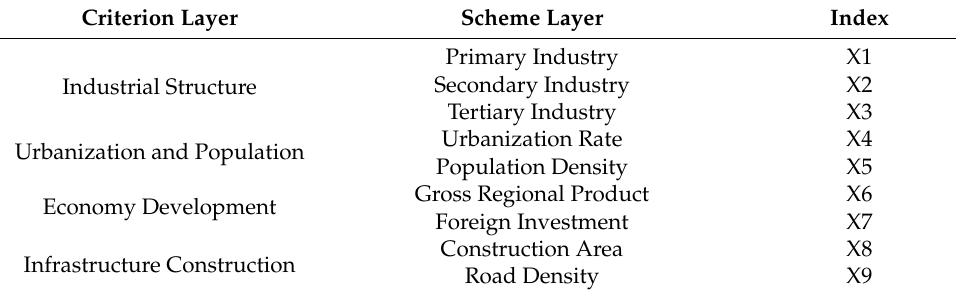
Table 2. Variable